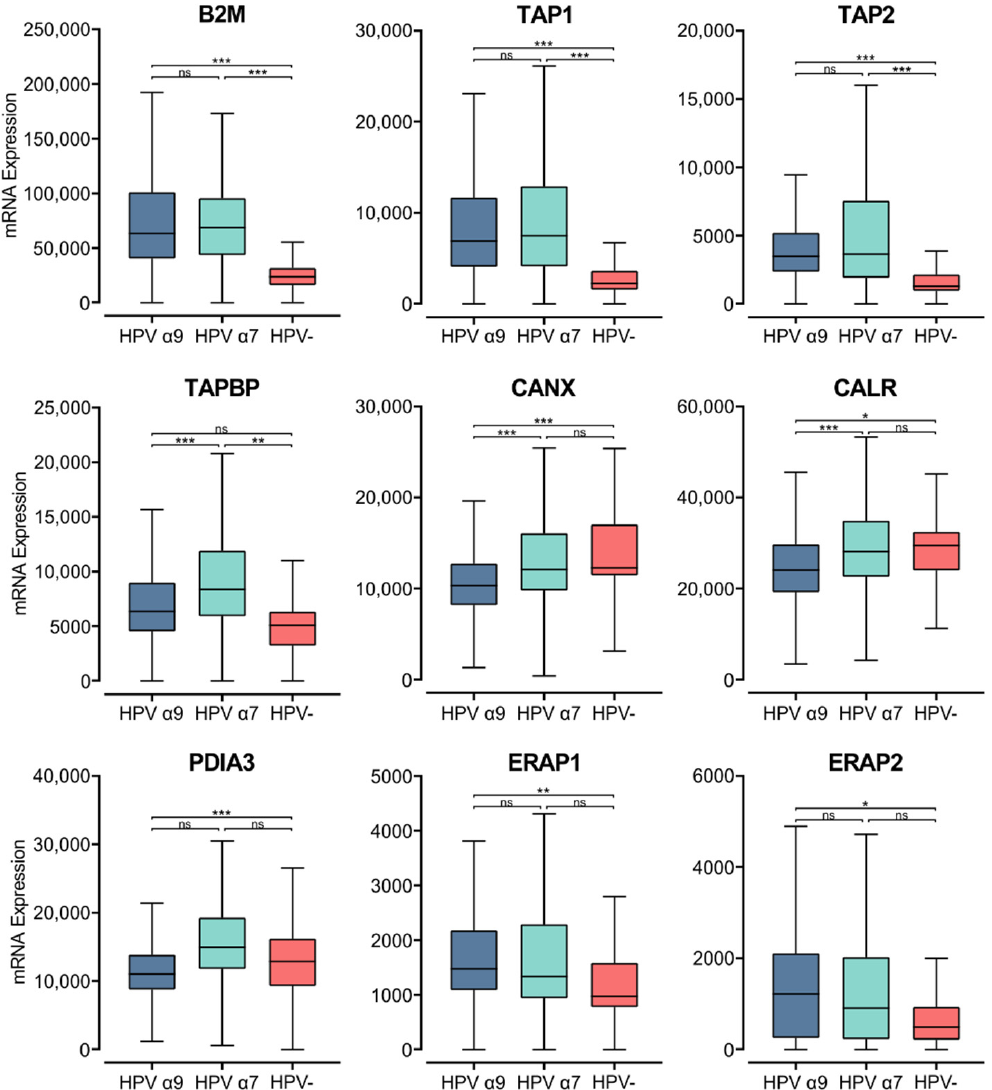
Figure 6. Expression of MHC class I light chain and other genes involved in antigen loading and presentation in CC stratified by HPV+ ( α 9 or α 7) and HPV − status. Normalized RNA-seq data for B2M as well as genes important in the MHC class I antigen presentation pathway were extracted from the CC cohort of the TCGA database. *** p ≤ 0.001, ** p ≤ 0.01, * p ≤ 0.05, ns (not significant).